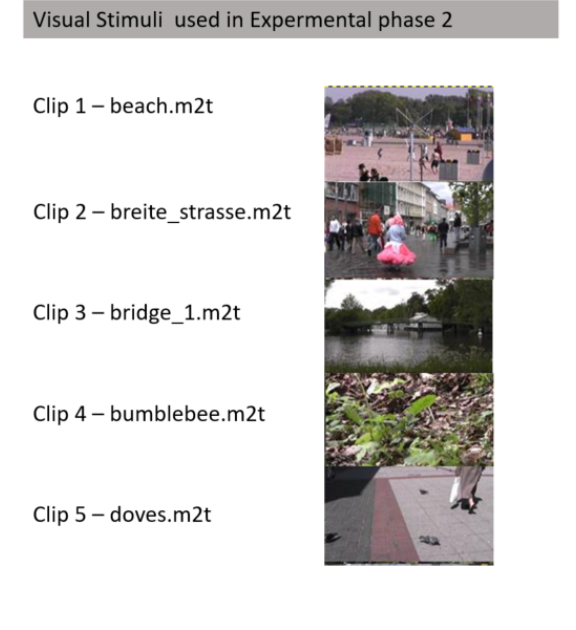
Figure 3. Pictures from the clips used as stimuli in the Experimental Phase #2 (on the right) and correspondence between the ordered clips used in this paper and their names in the original